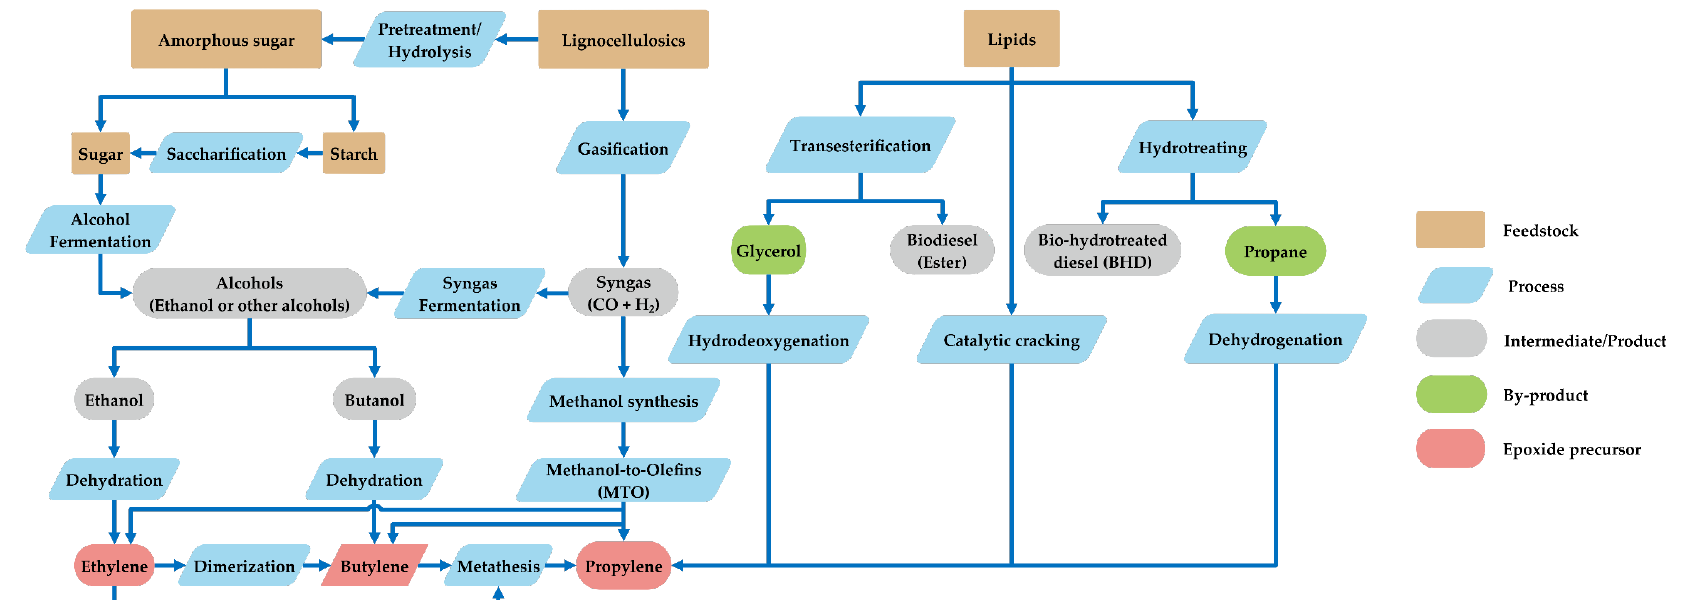
Figure 9. Possible pathways for generation of sustainable ethylene, propylene, and butylene as epoxide precursors.